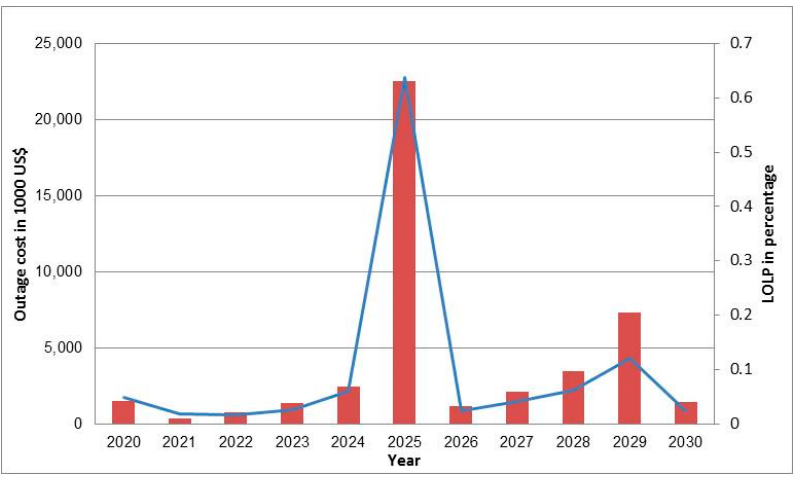
Figure 8. LOLP and outage costs (OC) in a scenario with LCP and VOLL $10 USD/kWh.